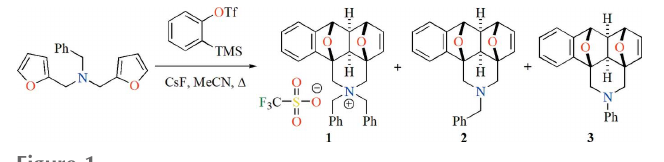
Figure 1 Synthesis scheme of the title compound 1 and its by-products.